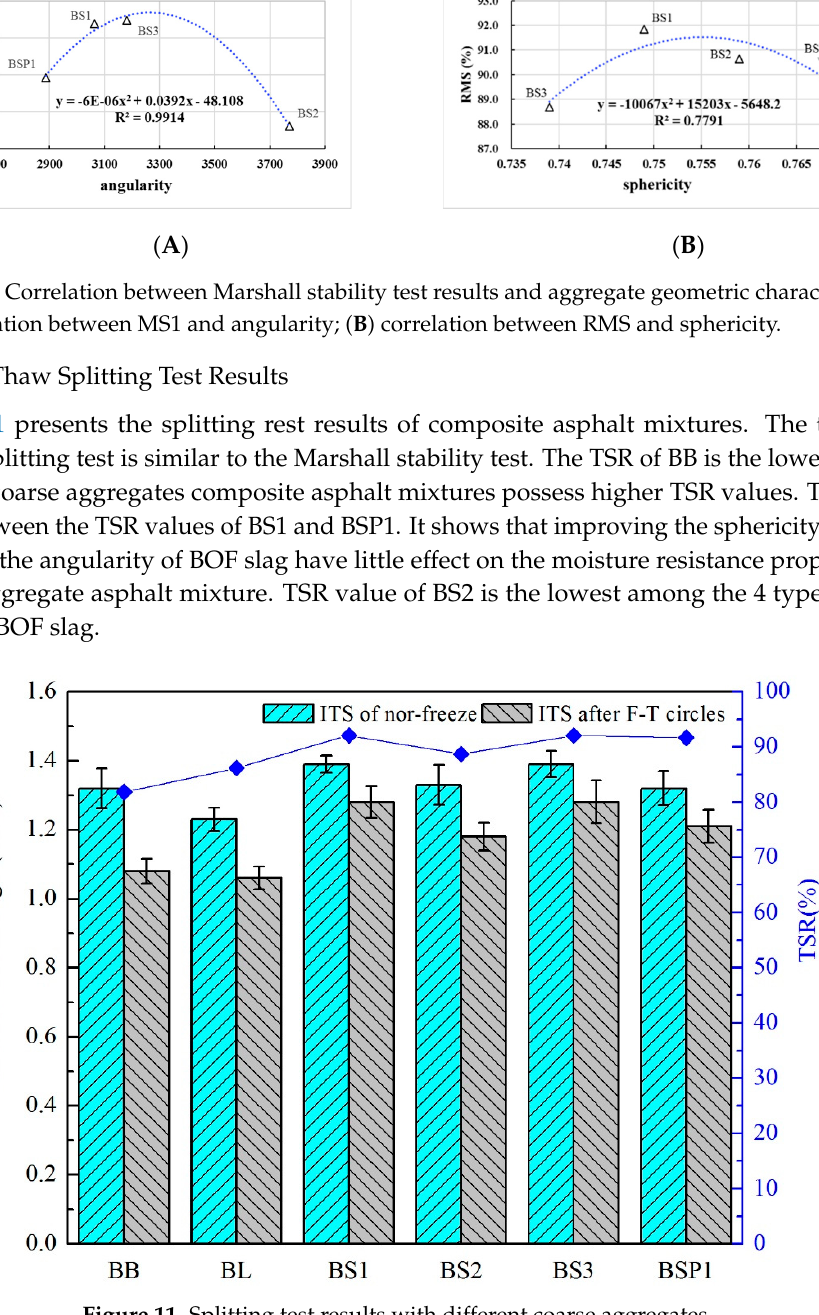
Figure 10. Correlation between Marshall stability test results and aggregate geometric characteristics.